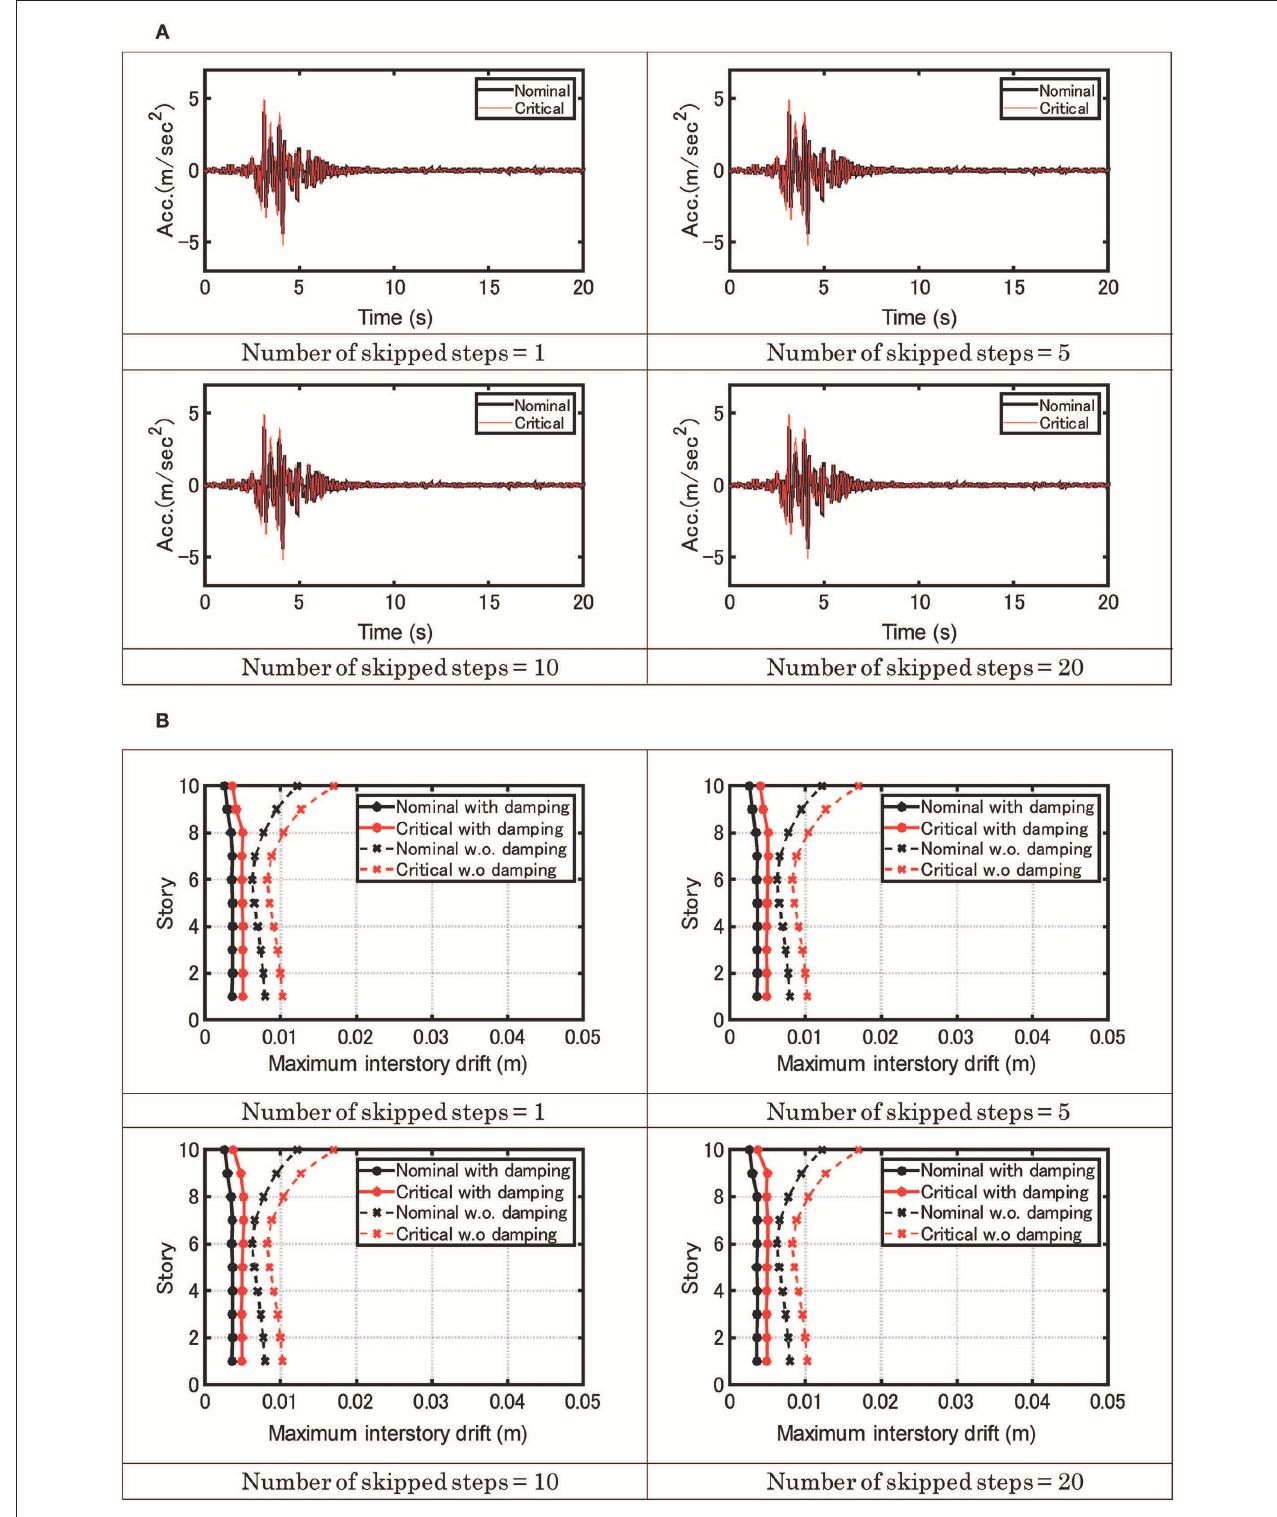
FIGURE 5 | Influence of number of skipped steps. (A) Acceleration of ground motions for four numbers of skipped steps. (B) Maximum interstory drift of MDOF model for four numbers of skipped steps.